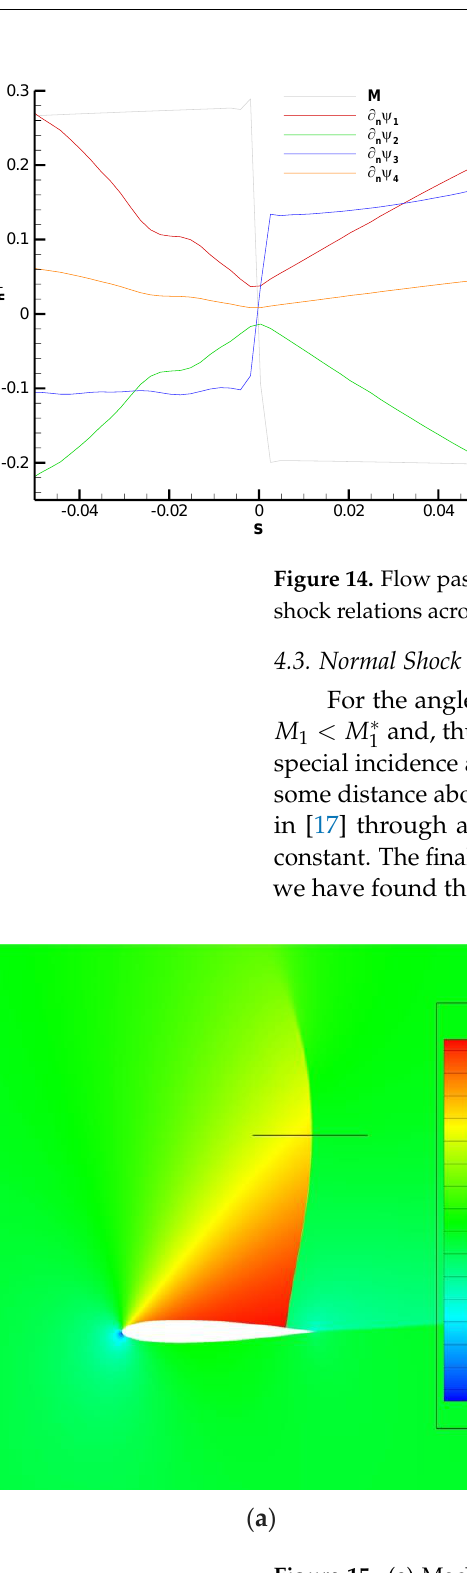
Figure 15. ( a ) Mach contours and cutting line and ( b ) surface Mach distribution for flow past a NACA0012 airfoil at M = 0.8 and α = 5.794°.